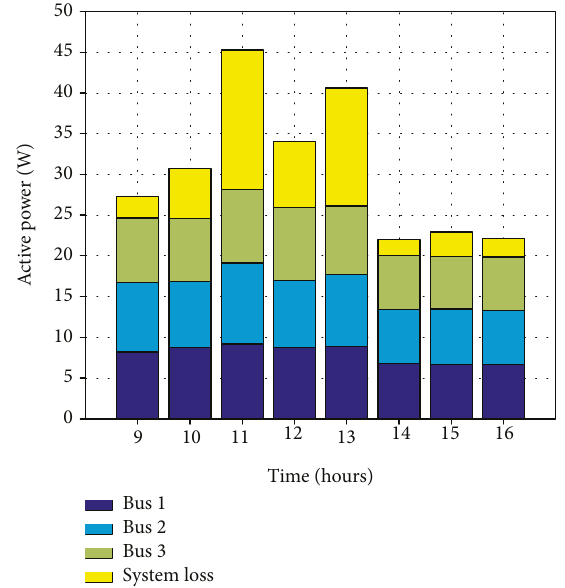
Figure 14: Distributed power in the experimental veri fi cation of single-source con fi guration.